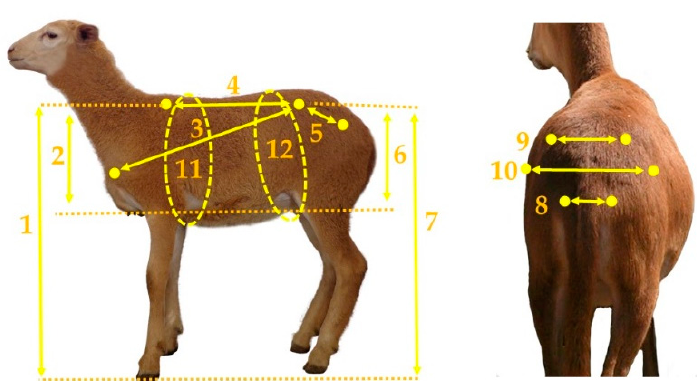
Figure 1. Body measurements taken in hair sheep lambs. ( 1 ) height at withers, ( 2 ) rib depth, ( 3 ) body diagonal length, ( 4 ) body length, ( 5 ) pelvic girdle length, ( 6 ) rump depth, ( 7 ) rump height, ( 8 ) pin bone width, ( 9 ) hook bone width, ( 10 ) abdomen width, ( 11 ) girth circumference, and ( 12 ) abdomen circumference. The lamb used as a reference was 56 days of age and 14.2 kg of live weight.